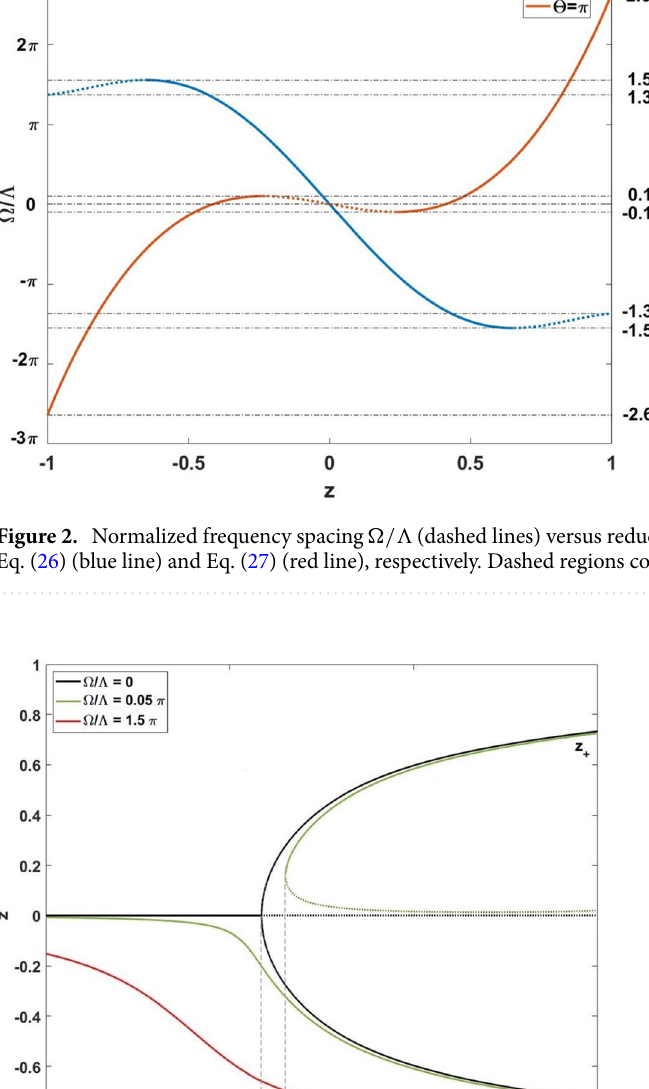
Figure 3. Population imbalance z versus (cid:31) for (cid:31) Eq. (24) and the dotted curves represent (parametrically) unstable solutions. (cid:31) c are critical distances between the solitons correspondent to bifurcations occurring for curves �/� 0.05 π , �/� =